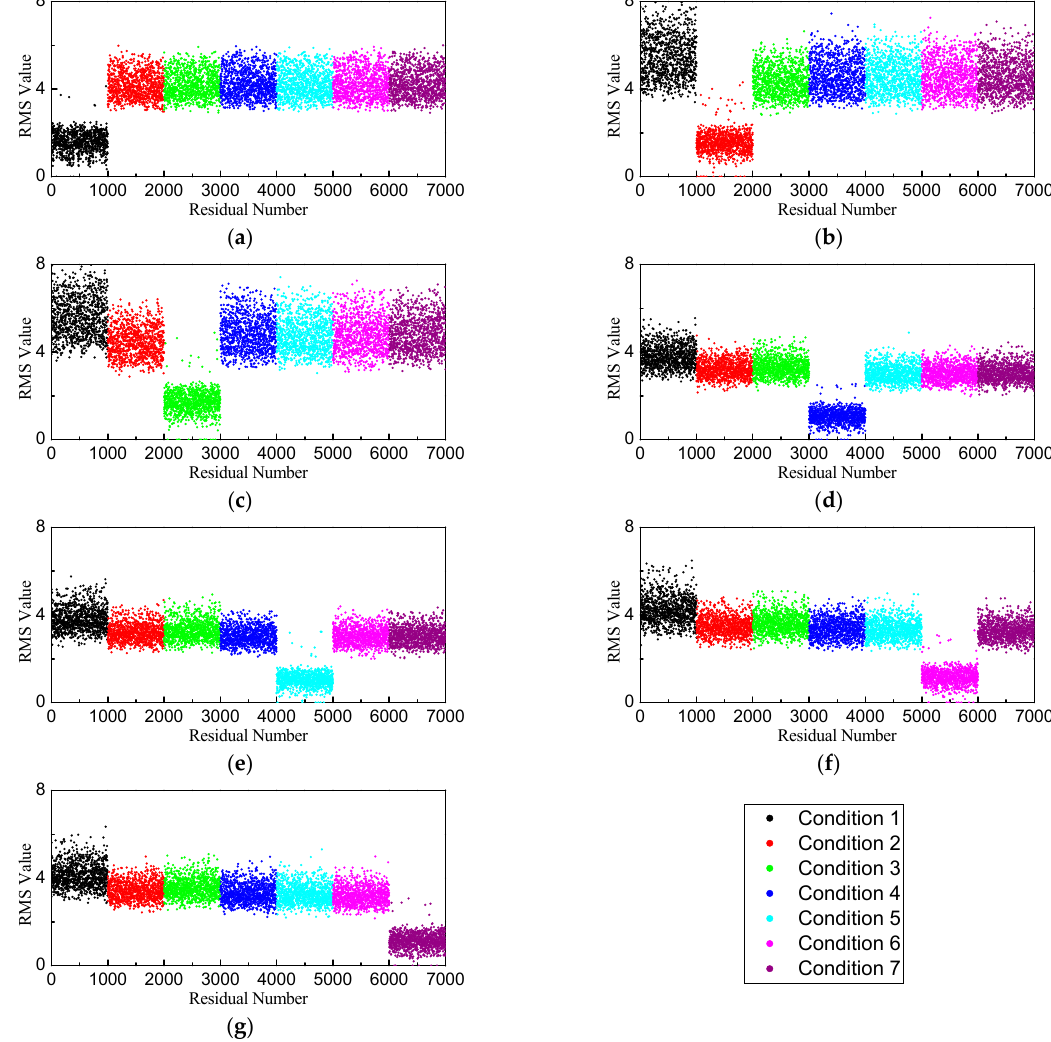
Figure 14. RMS value of residuals derived from signals of different conditions, where point color corresponds to number of conditions. Results by dictionary learned from: ( a ) Condition 1; ( b ) Condition 2; ( c ) Condition 3; ( d ) Condition 4; ( e ) Condition 5; ( f ) Condition 6; ( g ) Condition 7.